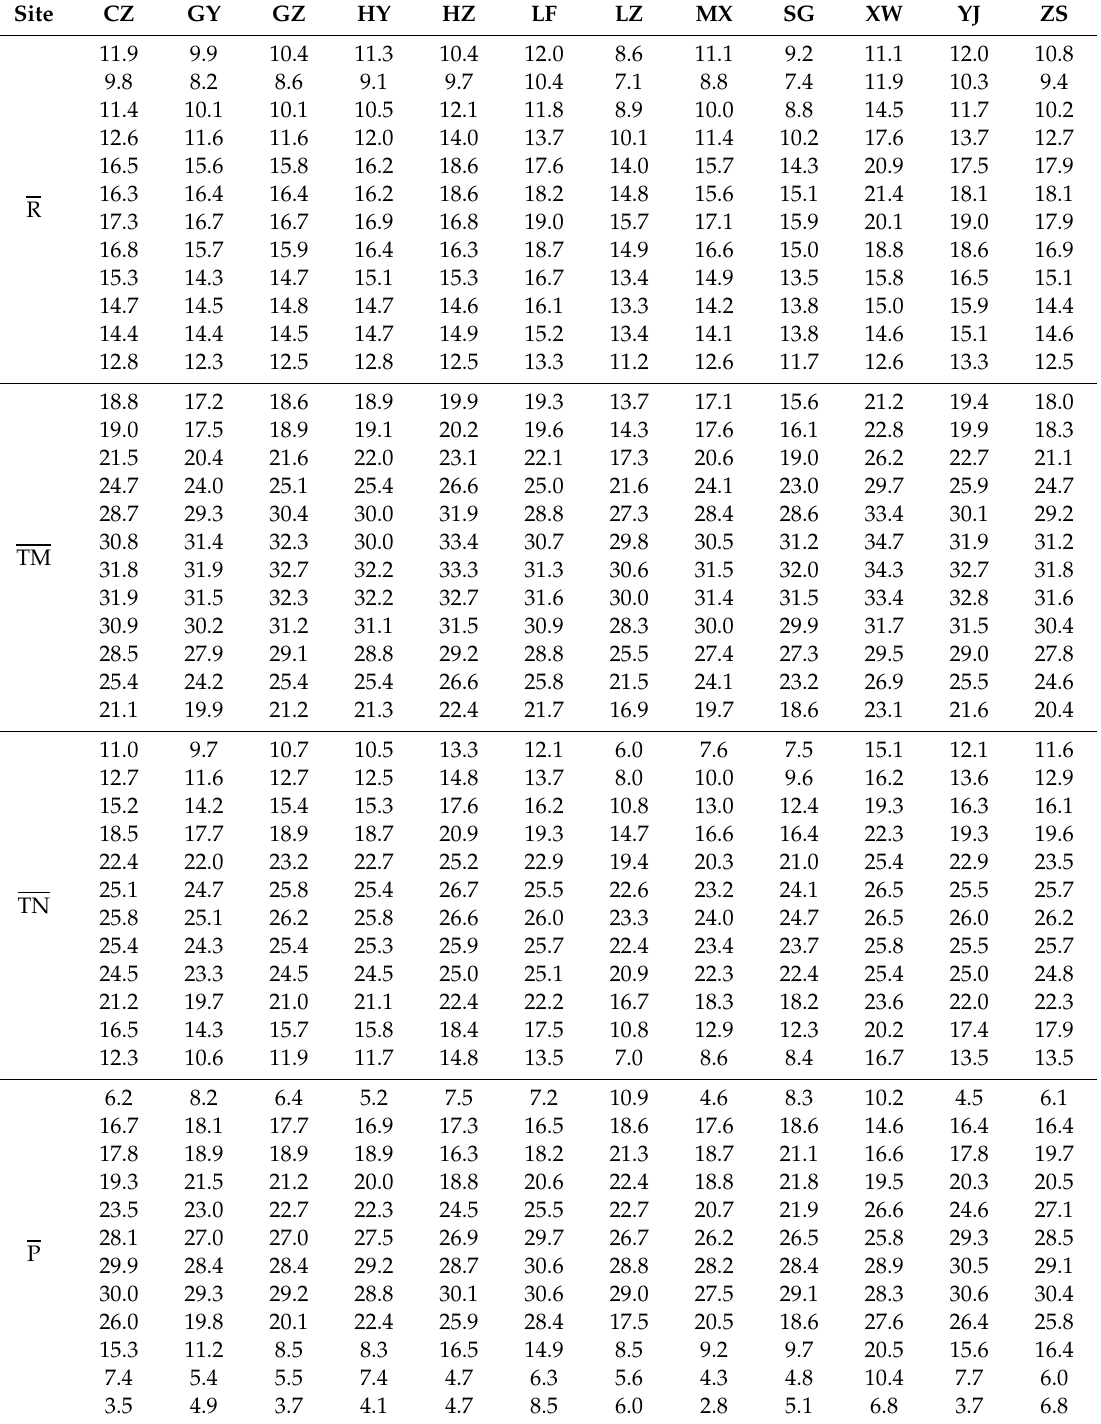
Table A4. Climate patterns under historic conditions. The rows are ordered from January to December.